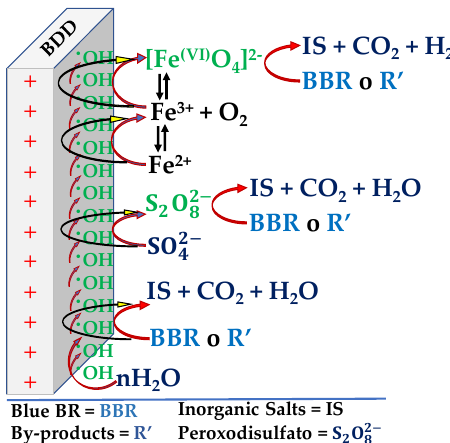
Scheme 1. Representation of the reactions involved on BDD substrate electrode held in FeSO 4 and 0.1 M of HClO 4 .